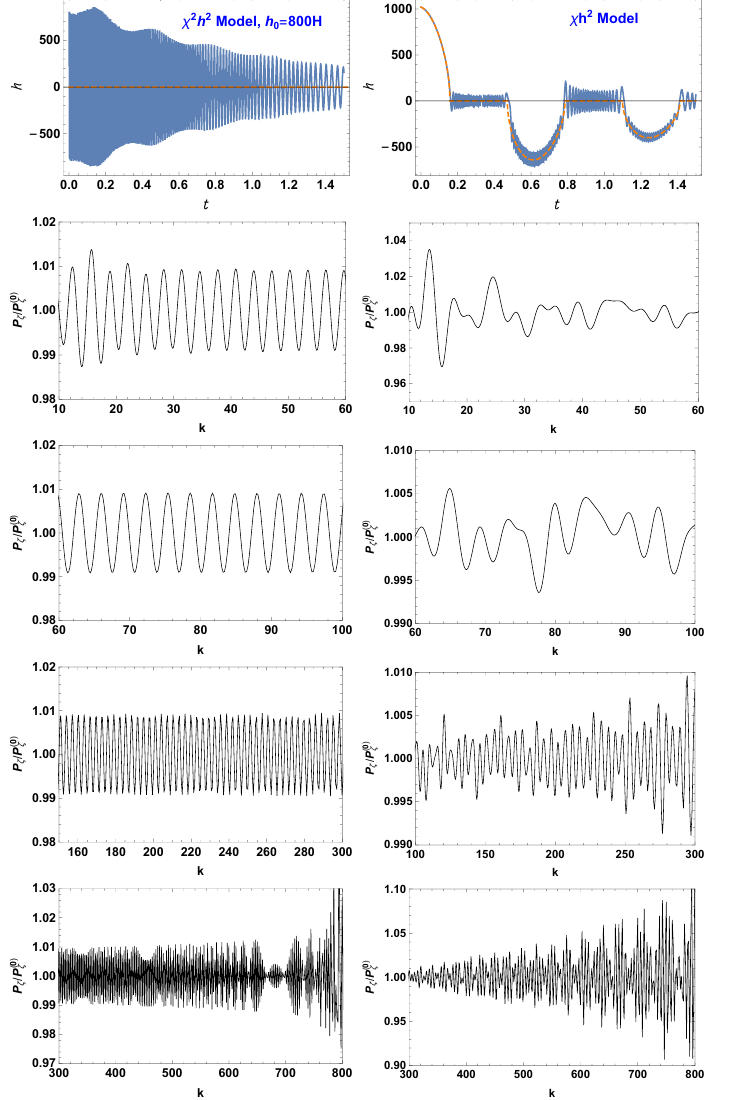
Figure 9 . The (cid:12)rst column corresponds to M 2